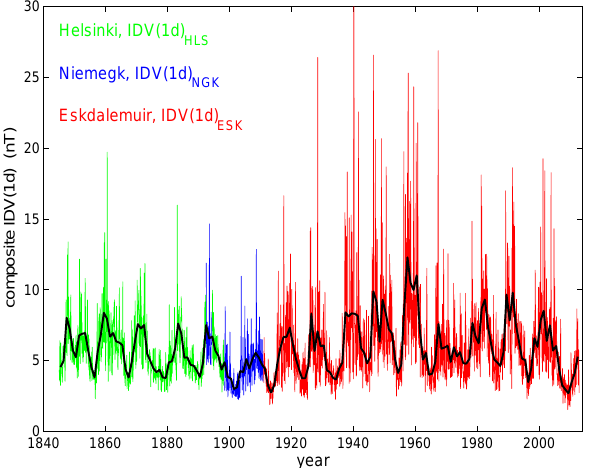
Fig. 11. The composite variation (normalised to the Eskdalemuir site in 2000 using the station-latitude correction factor shown in Fig. 10, bottom panel). The coloured lines show 27d Bartels rota- tion means (red for data originating from ESK, blue for NGK and green from HLS), and the black line shows annual means.